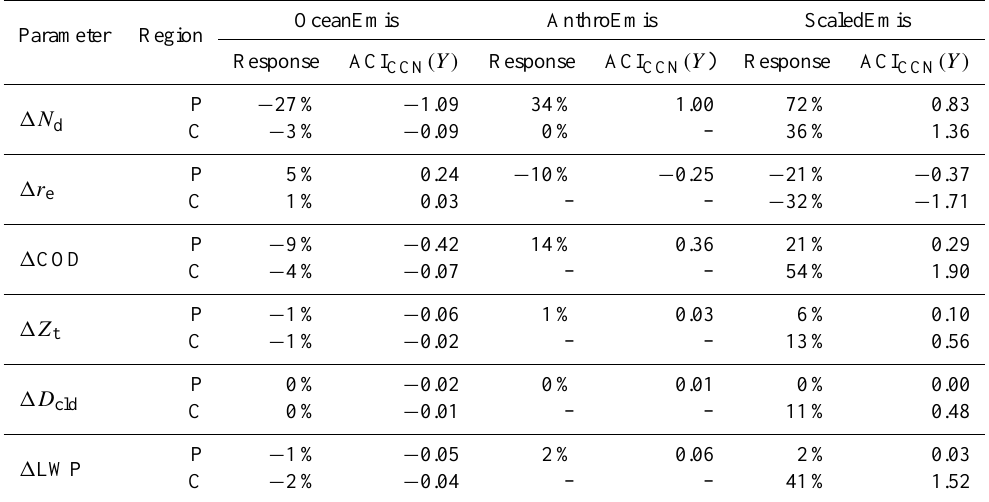
Table 2. The mean responses and aerosol-cloud interaction indices associated with regional oceanic (OceanEmis), regional anthropogenic (AnthroEmis), and enhanced regional anthropogenic emissions